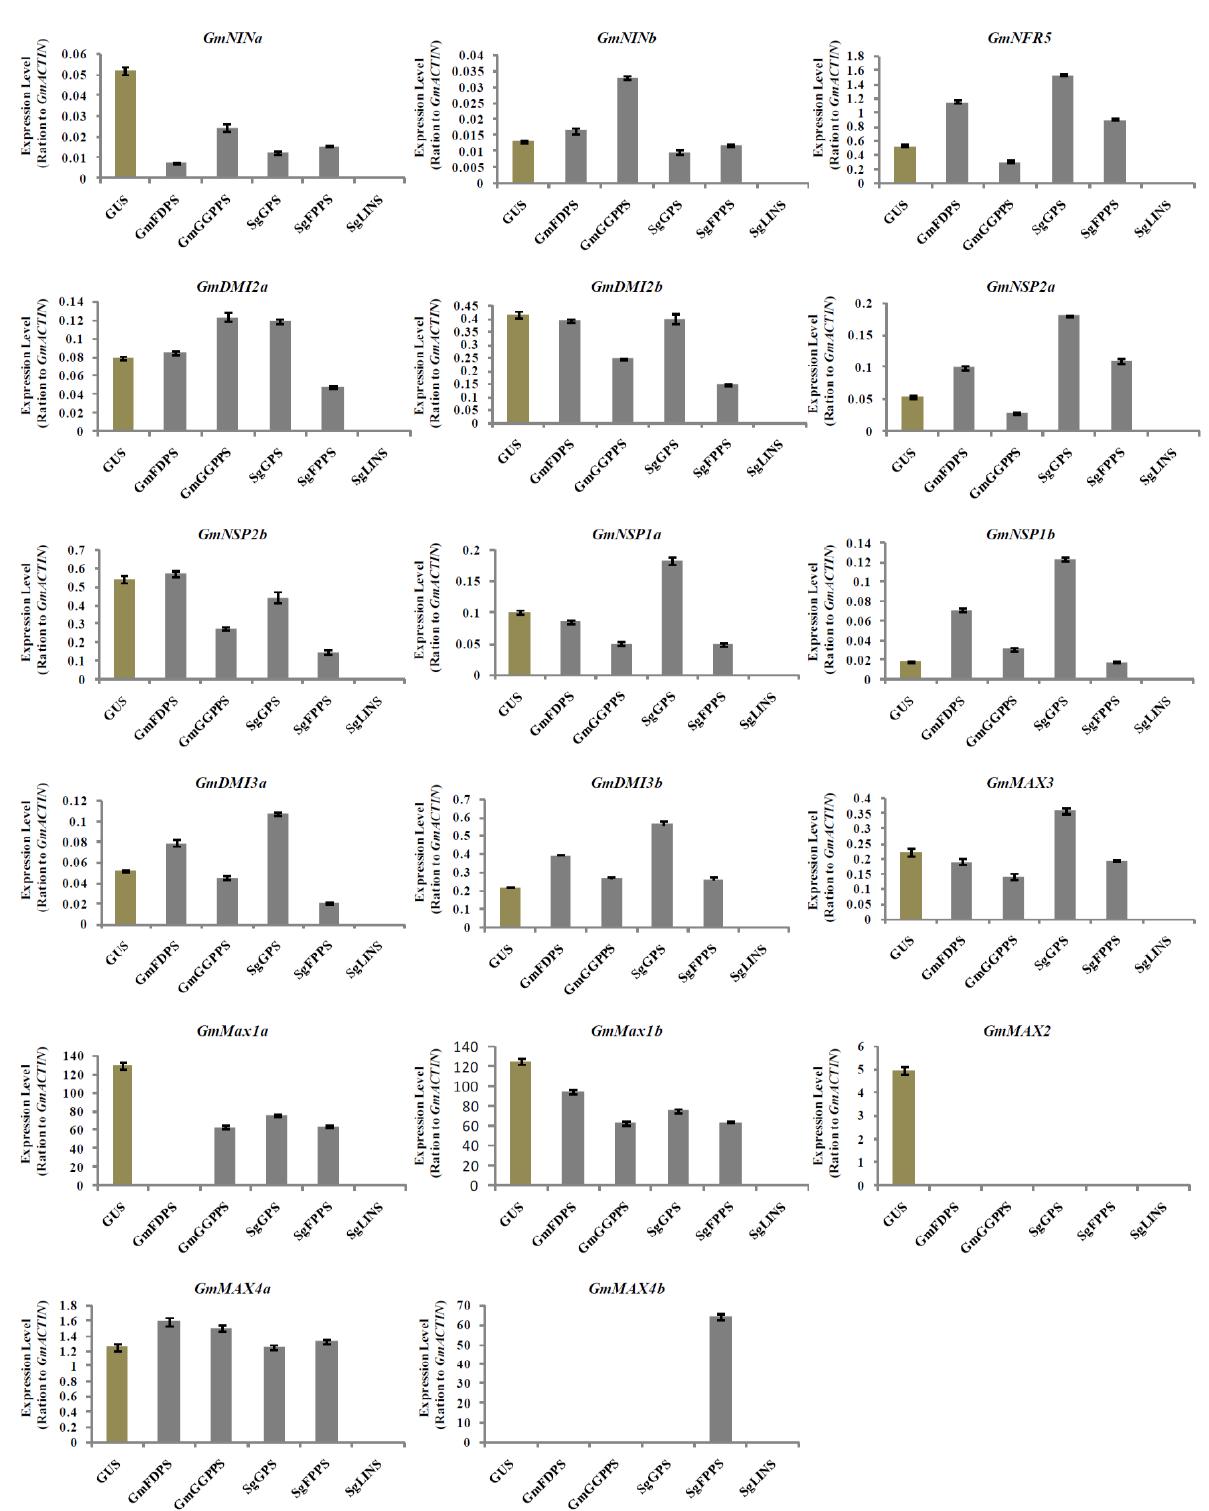
Figure 6. Expression profiles of SL biosynthesis and nodulation genes in soybean nodules after 10 days of rhizobia inoculation.Gene expression was analyzed using quantitative real-time PCR as compared to GUS as a control. The housekeeping GmB-ACTIN gene was used as an internal reference gene for expression normalization. The error bars indicate the SD of three qRT-PCR biological replicates.